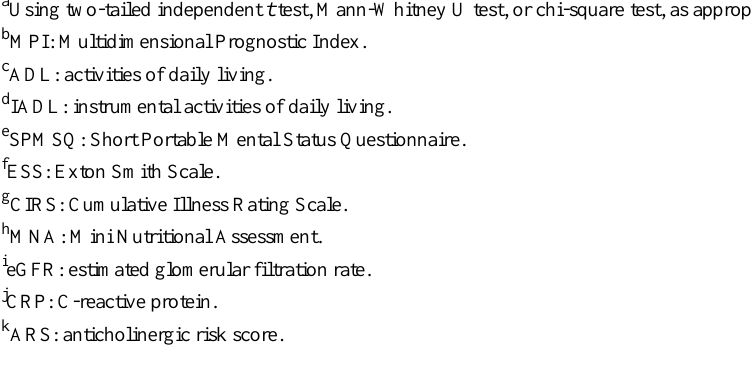
P value a Deceased (n=201)Alive